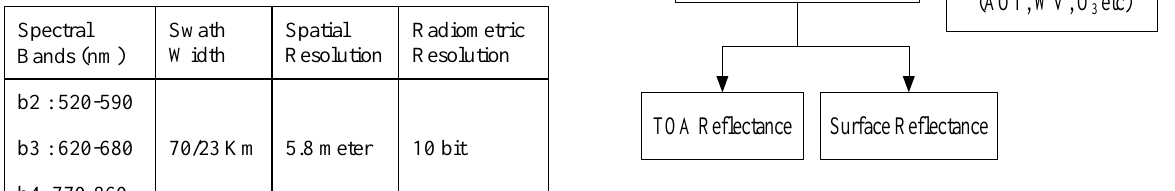
Figure 4. Flow diagram of atmospheric